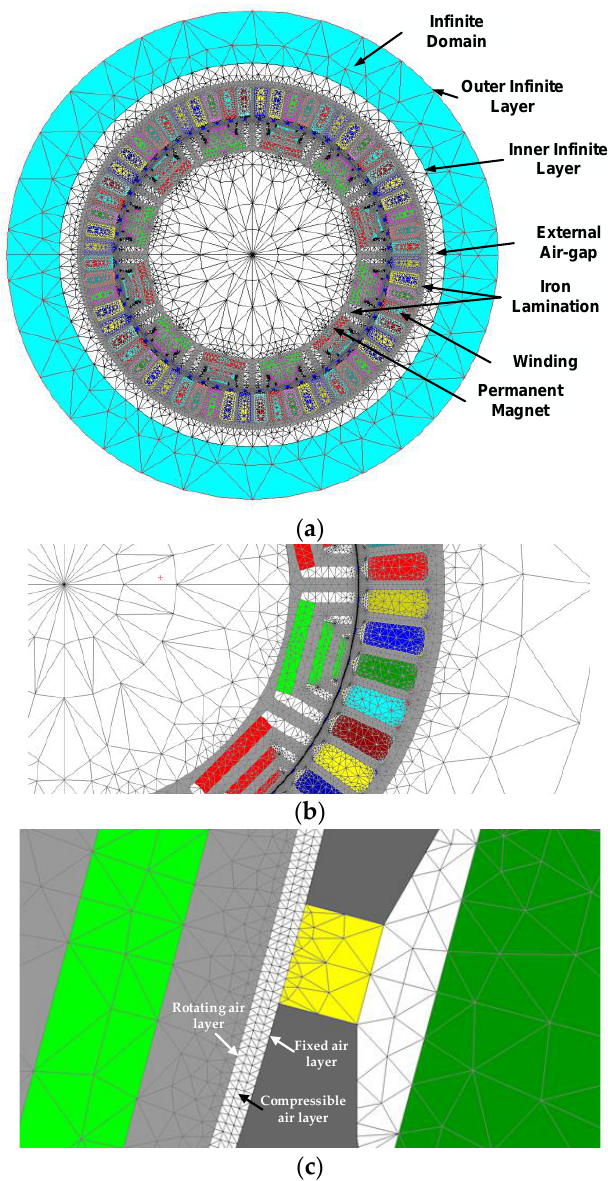
Figure 3. ( a ) The mesh of the full machine. The mesh includes about 152,000 nodes, 25,000 line elements and 75,000 surface elements. ( b ) Detail of the mesh. ( c ) Detail of the slot opening and the three layers to model the air